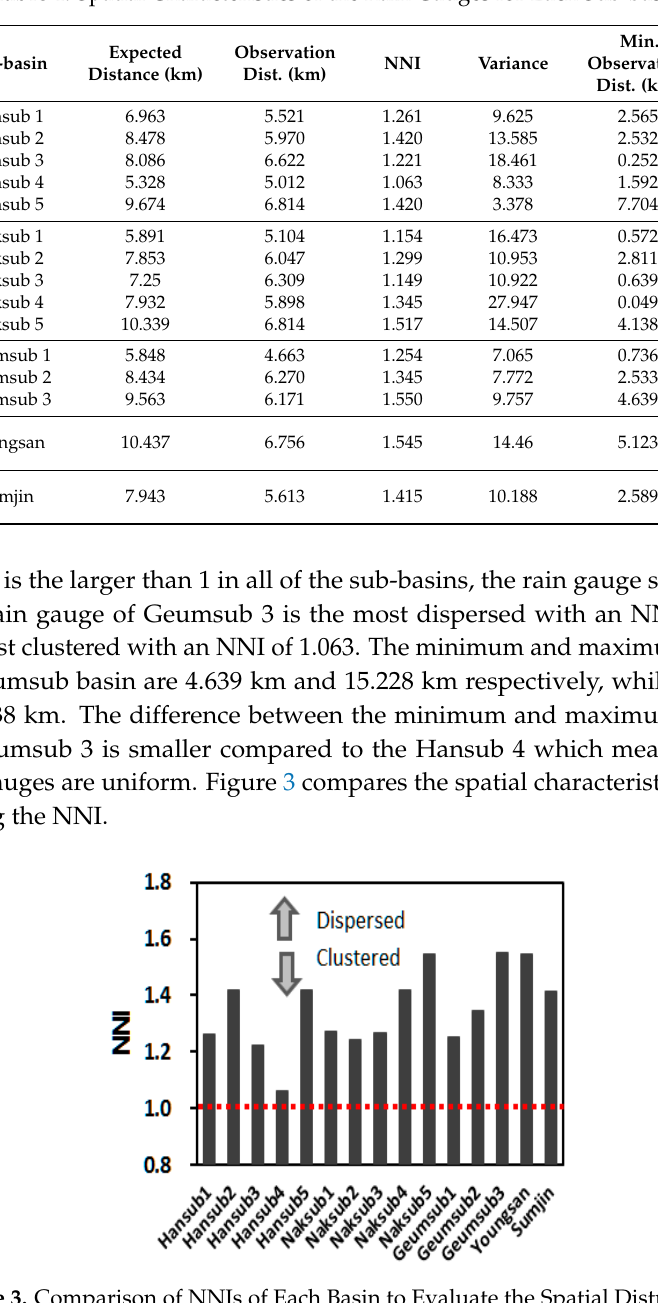
Table 4. Spatial Characteristics of the Rain Gauges for Each Sub-basin.